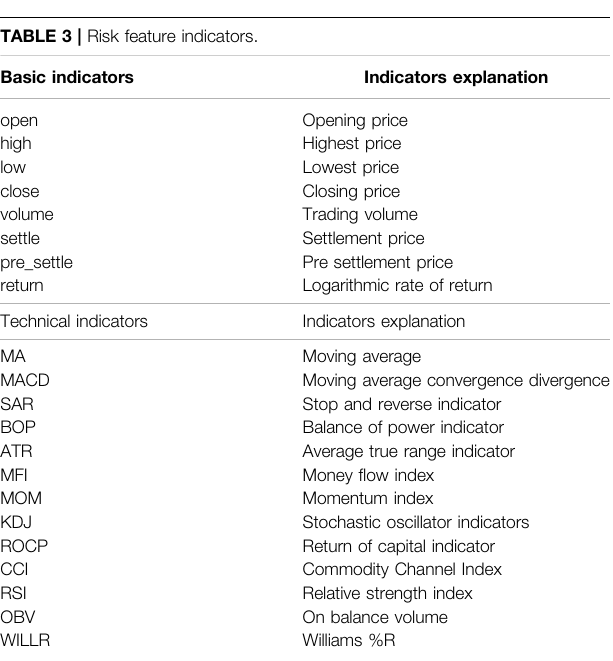
TABLE 3 | Risk feature